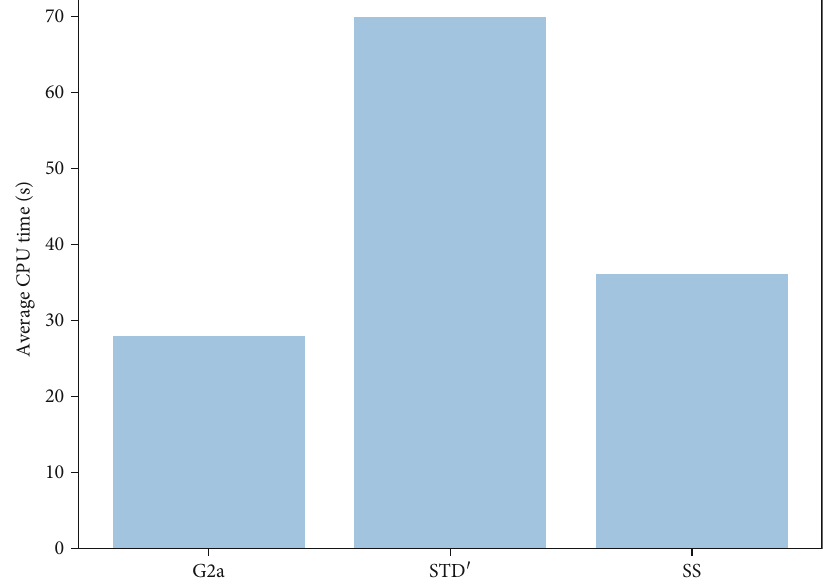
Figure 12: Average CPU times (s) over all problem classes.